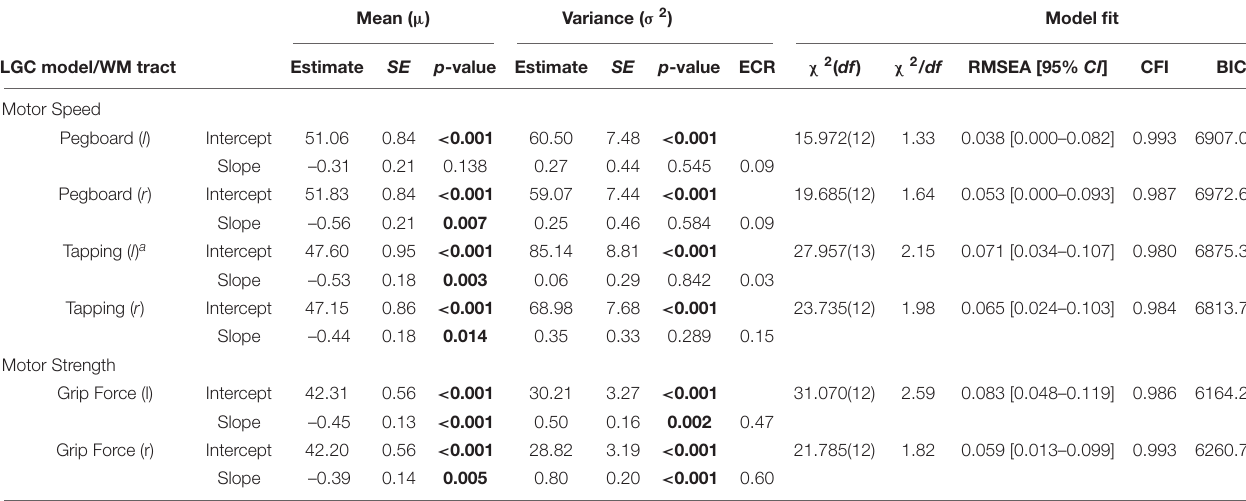
TABLE 6 | Parameter estimates and model fit statistics of best fitting univariate LGC models for motor function.